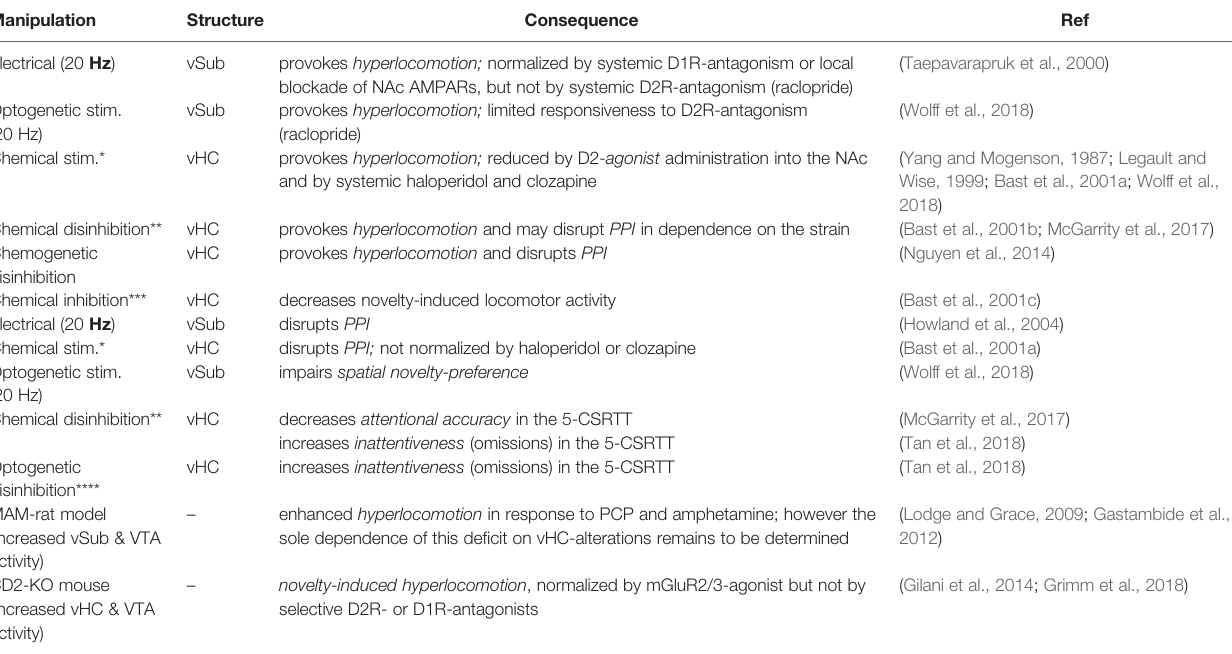
TABLE 3 | Experiments demonstrating the control of dopamine- and salience-related behaviors by the rodent ventral hippocampus.